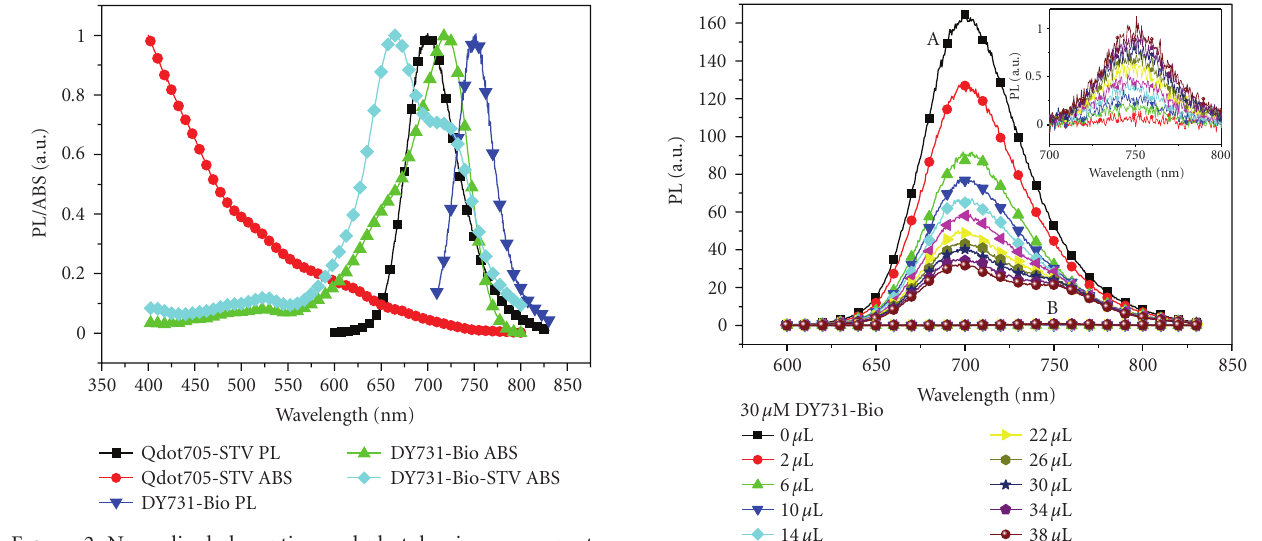
Figure 2: Normalised absorption and photoluminescence spectra of Qdot705-STV, DY731-Bio, and DY731-Bio-STV.